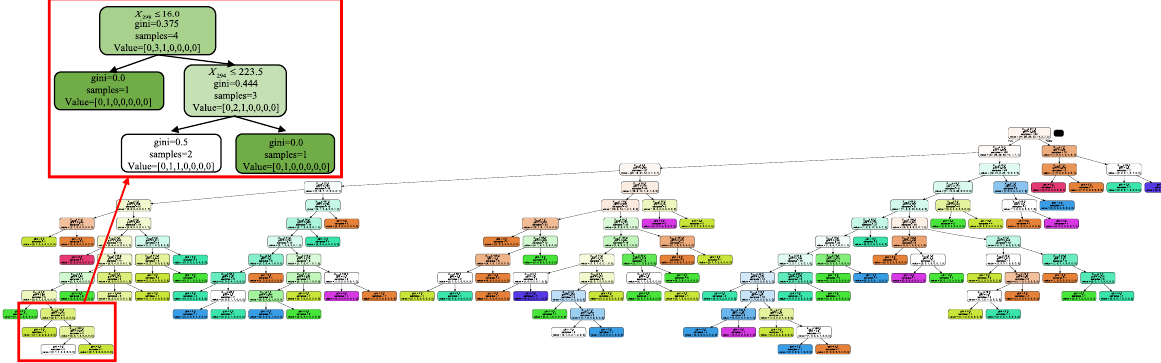
Fig. 12 One of the RF trees when the number of training samples is 200, and the embedding model is